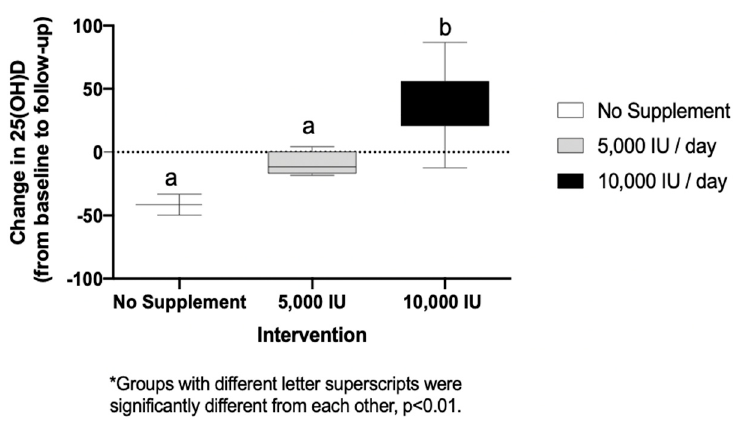
Figure 1. Change of 25(OH)D concentrations (nmol/L) by intervention group.